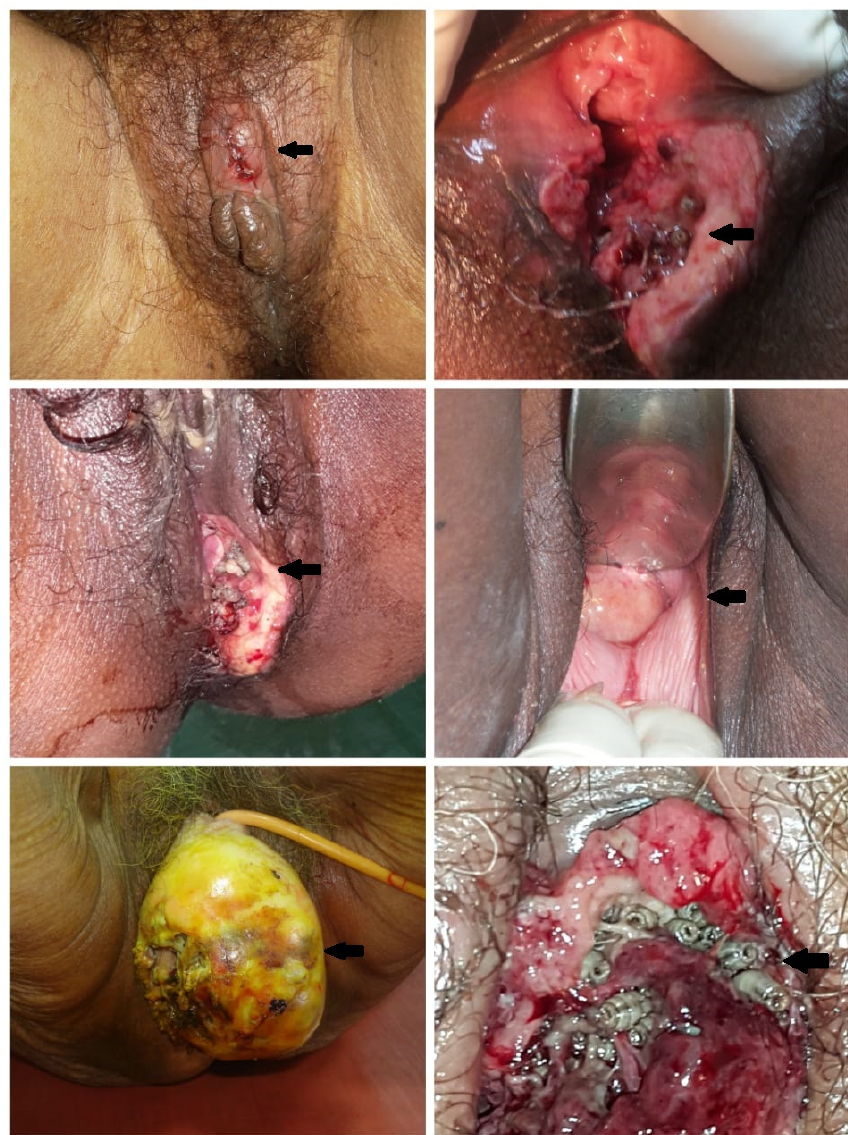
Figure 1. An illustration of infested vaginas during the case